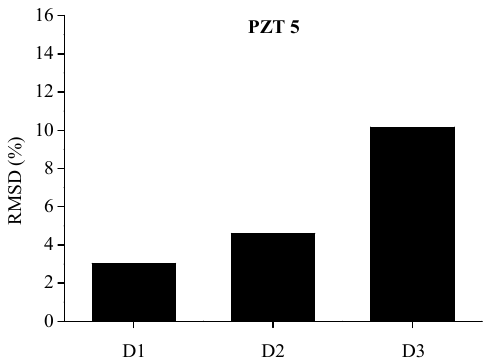
Figure 12. Experimental RMSD values of each PZT sensor for BE2 under different damage levels.